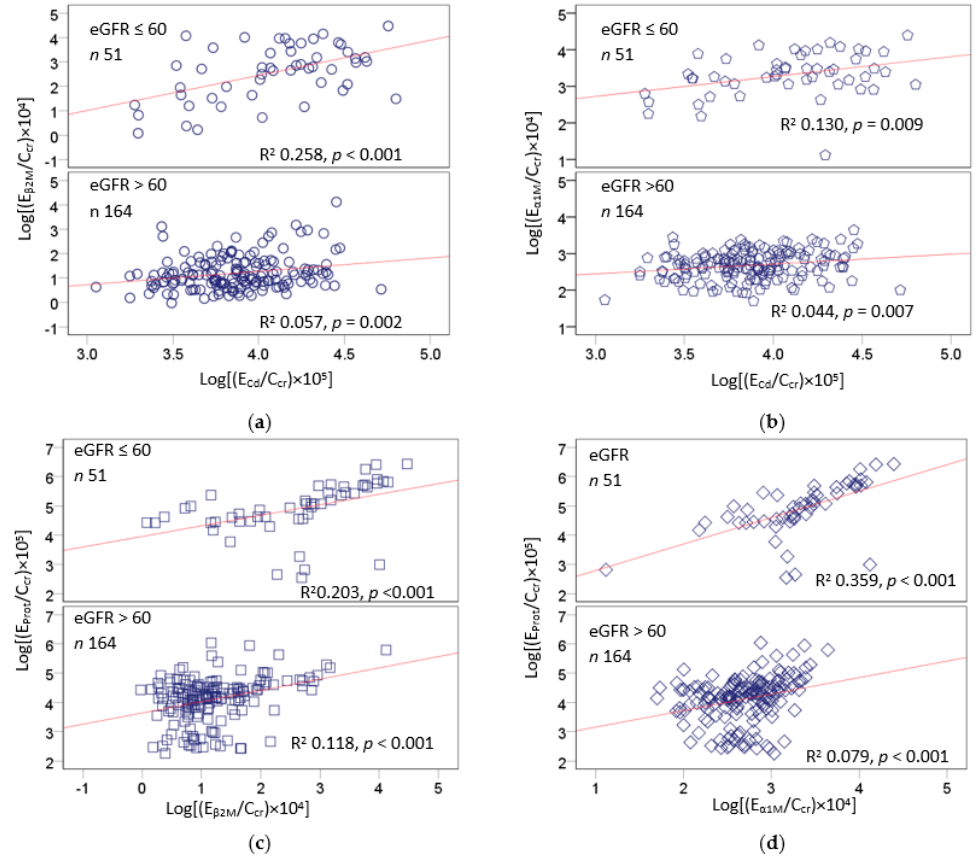
Figure 1. Effects of cadmium exposure and nephron mass on excretion of β 2 -microglobulin and α 1 - microglobulin. Scatterplot ( a ) relates log[(E β M /C cr ) × 10 4 ] to log[(E Cd /C cr ) × 10 5 ]. Scatterplot ( b ) relates log[(E α 1M /C cr ) × 10 4 ] to log[(E C d/C cr ) × 10 5 ]. Scatterplot ( c ) relates log[(E Prot /C cr ) × 10 5 ] to log[(E β 2M /C cr ) × 10 4 ]. Scatterplot ( d ) relates log[(E Prot /C cr ) × 10 5 ] to log[(E α 1M /C cr ) × 10 4 ] ( d ). Units of E β 2M /C cr , E α 1M /C cr , and E Prot /C cr are mg/L of filtrate, and the unit of E Cd /C cr is μ g/L of filtrate. Coefficients of determination (R 2 ) and p -values are provided for all scatterplots.